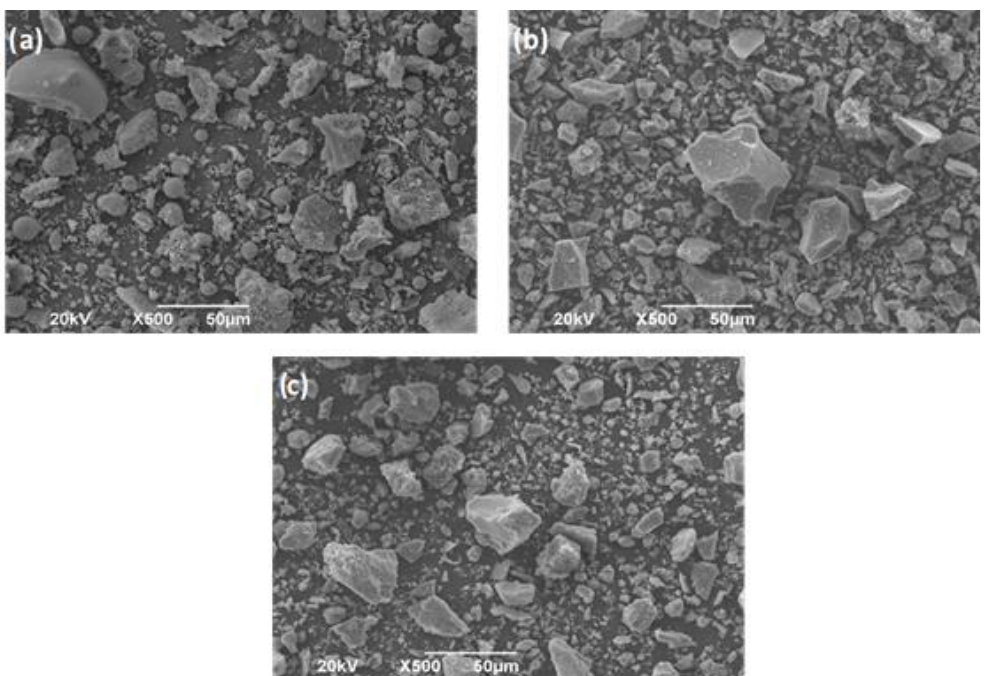
Figure 1. SEM micrograph of raw materials ( a ) FA, ( b ) GBFS y ( c ) OPC.